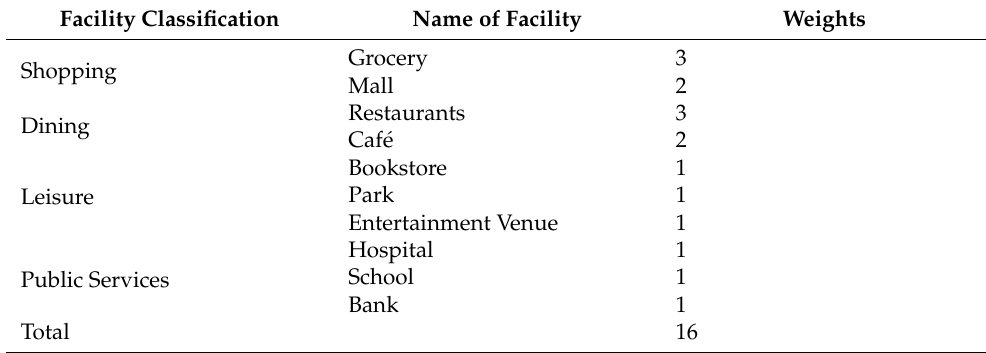
Table 1. Classification and weighting of service facilities.